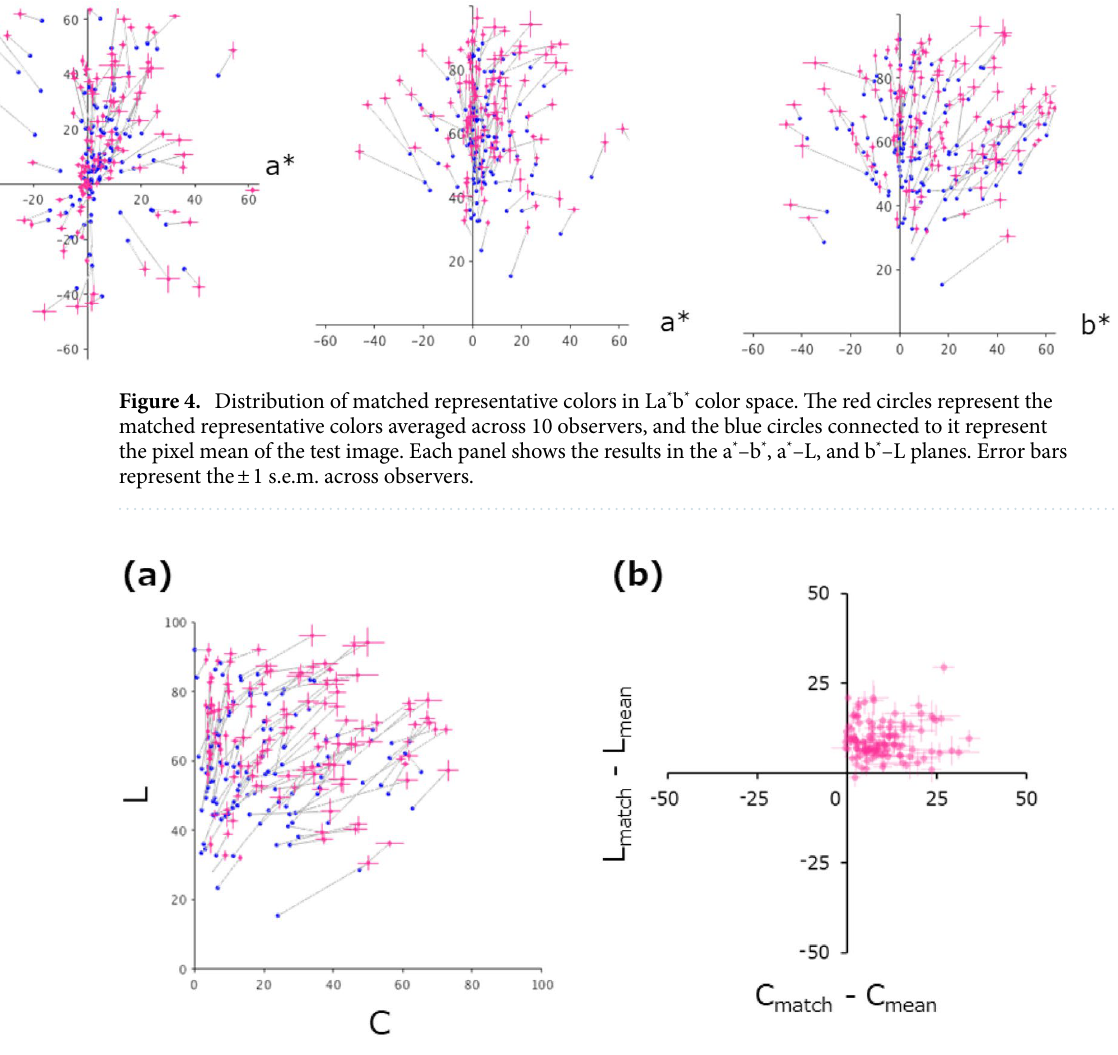
Figure 5. ( a ) Distribution of matched representative colors in the L-chroma plane. The red circles represent the matched representative color, and the blue circle connected to it by a line represents the pixel mean of the test image. ( b ) Difference between the matched representative color and the pixel mean of the image. Positive values indicate that the matched color had a higher lightness (Y-axis) and chroma (X-axis) than the image mean. Error bars represent the ± 1 s.e.m. across